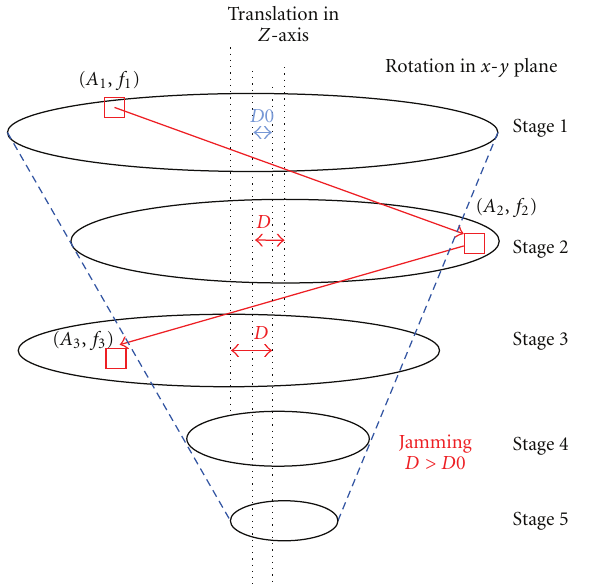
Figure 11: Choice of another optimal